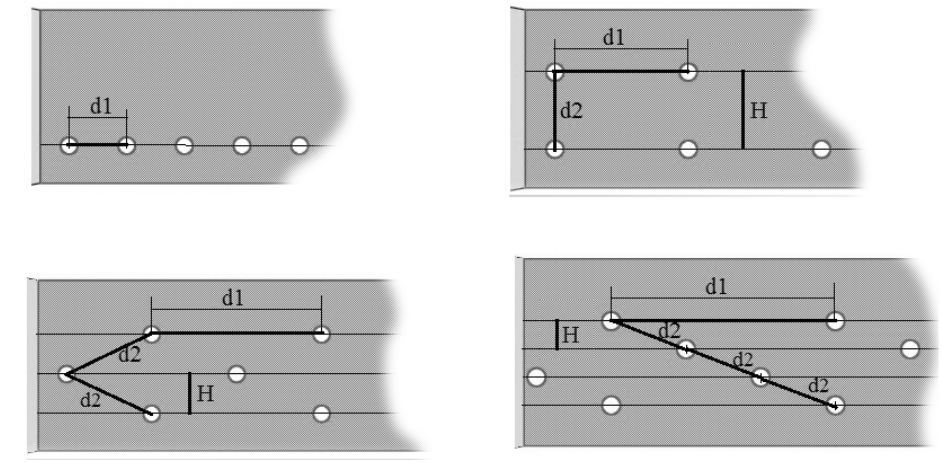
Figure 12. Diagrams of film-hole configuration and its main